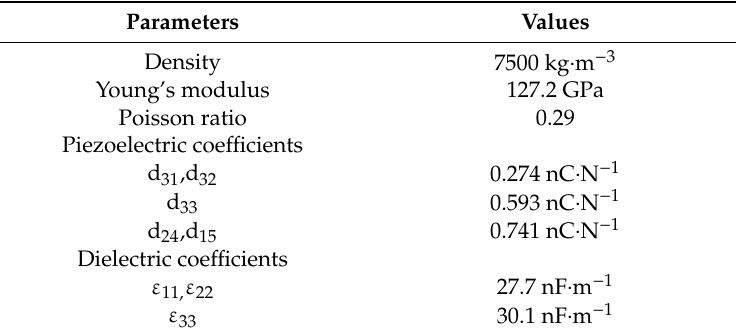
Table 2. Material properties of PZT-5H.